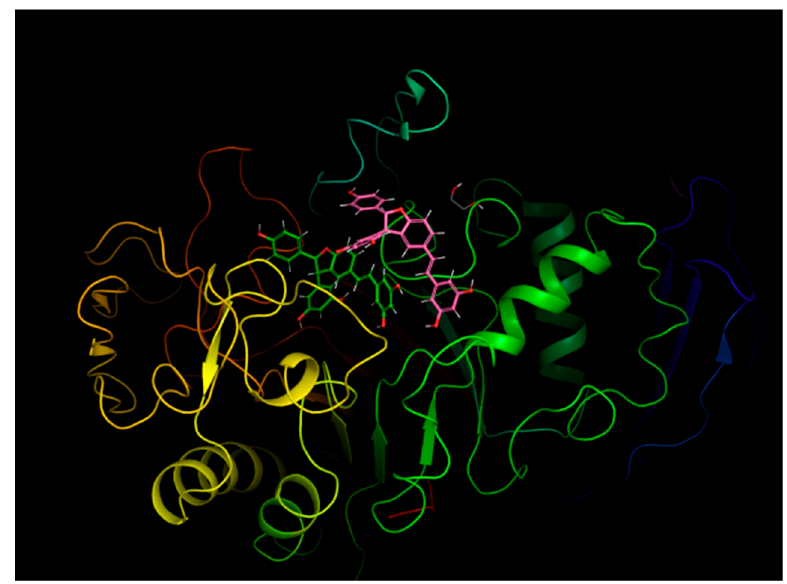
Figure 10. Top scoring pose of ( R , R )- trans - δ -viniferin to the pig pancreatic alpha amylase with ( S , S )- trans - δ -viniferin already bound to its active site.